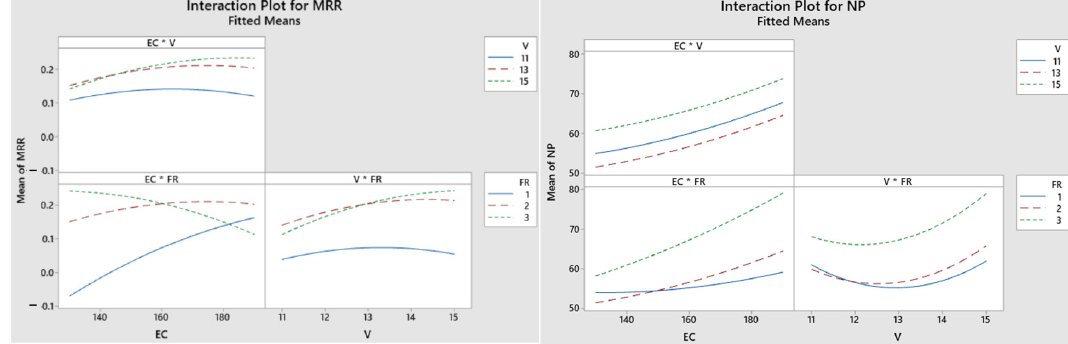
Figure 10. Interaction plots for MRR and NP.